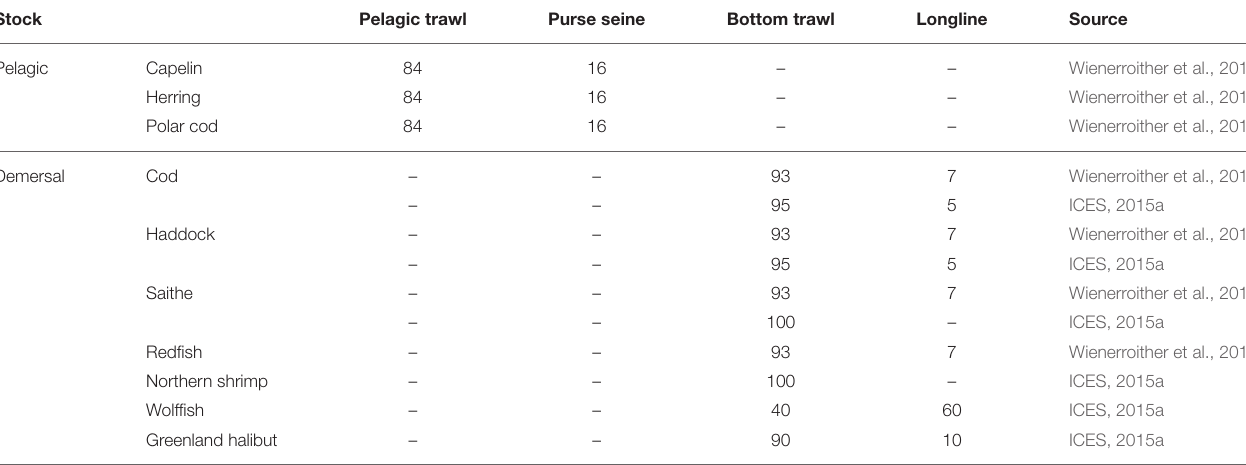
TABLE 3 | Percentage composition of catch by fishing gear types within Russian Barents Sea fisheries.